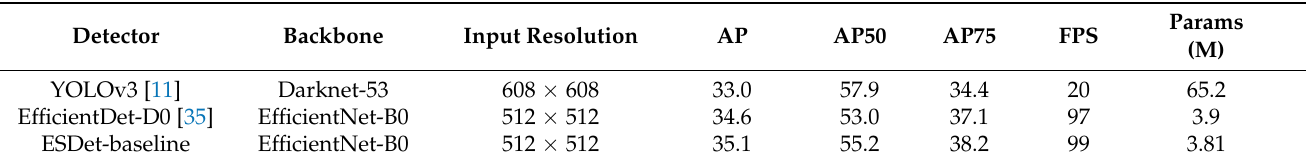
Table 5. Detection results on PASCAL VOC 07 test data set. All networks were trained using VOC 07 and VOC 12 train sets.